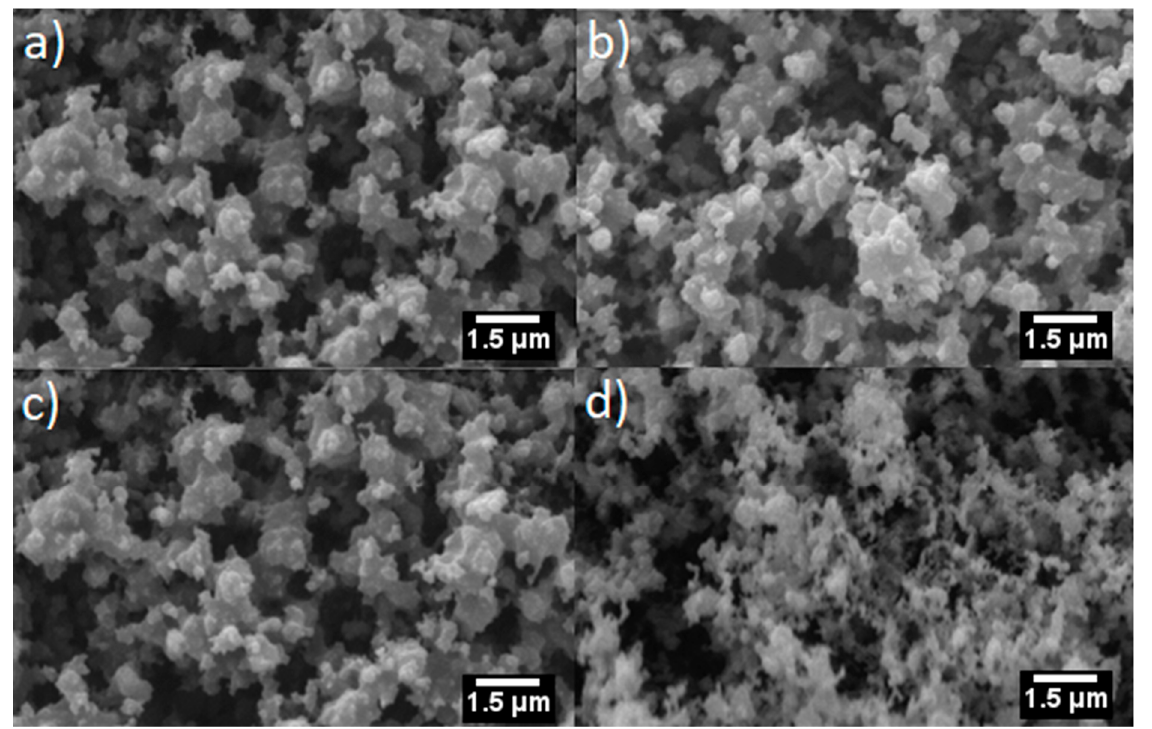
Figure 3. Morphology and structure of the soot coating ( a , c ) in the unaffected areas and ( b , d ) after laser irradiation with p = 114 mW for 350 and 450 s, respectively.